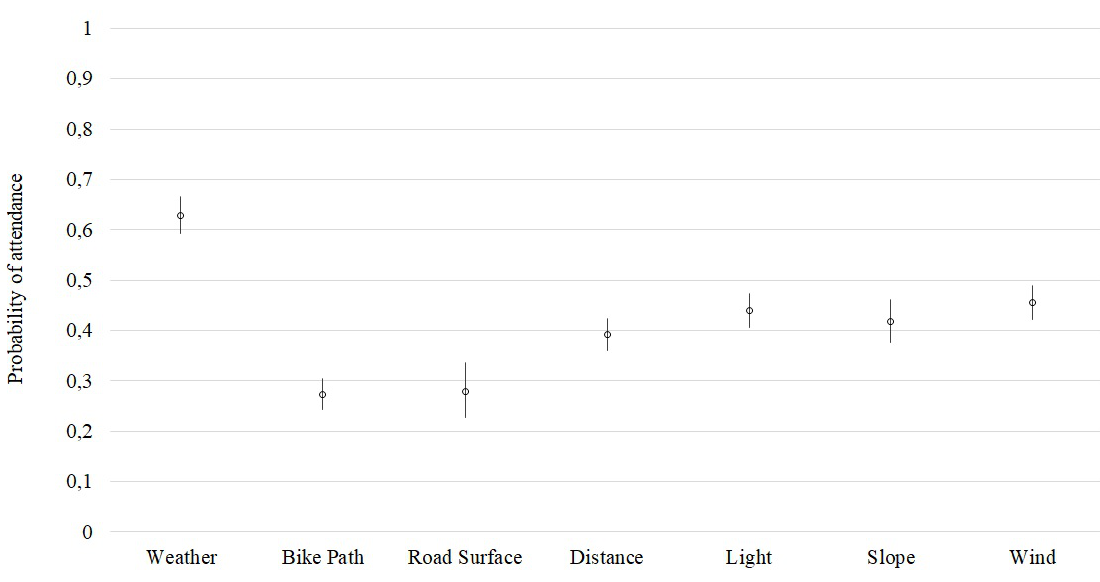
Figure 11. The estimated 95% bootstrapped confidence intervals for the frequency of taking the bike. Another possible model that can be an appropriate candidate to model the data is the mixed item response model where in addition to the intercept, some or all of the parameters are random across persons. This model has been used widely in the literature because of its ability to capture the heterogeneity among persons. We estimated the full mixed model with independent random parameters using the “gmnl” package in R (Sarrias and Daziano, 2017). The resulting AIC and BIC values were 10870 and 11050 respectively. The random-intercept ANA model with two latent classes has a better fit both in terms of AIC and BIC. Furthermore, it should also be noted that estimating the ANA model was much faster than estimating the full mixed model.